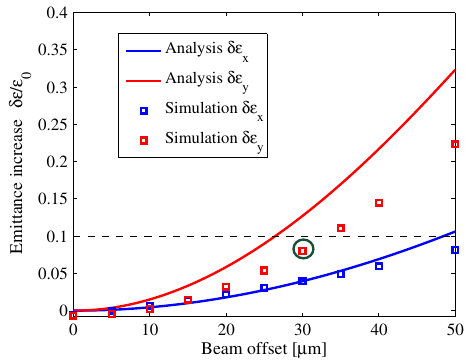
FIG. 13. Projected emittance growth versus the beam offset. Vertical (horizontal) offset leads to vertical (horizontal) emittance growth.